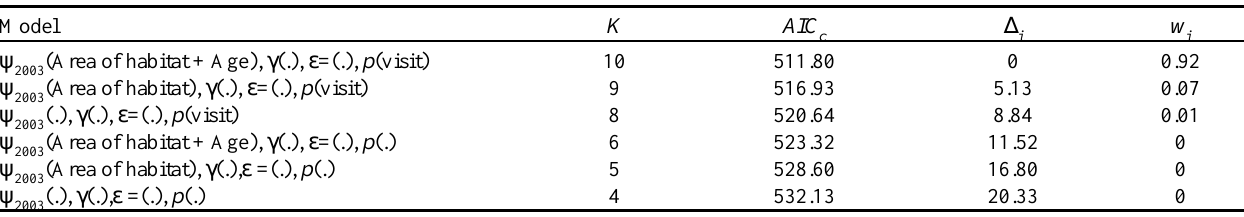
Table 2 . Multiseason occupancy of clear-cuts (n = 97) by Wilson’s Warbler ( Cardellina pusilla ), as a function of clear-cut age and area at Forêt Montmorency, Québec, 2003-2004. Age = age years since clear-cut. Area of habitat (clear-cut or alder, Alnus spp.) was calculated within 400 m of point-count stations. See Table 1 legend for other symbol definitions.